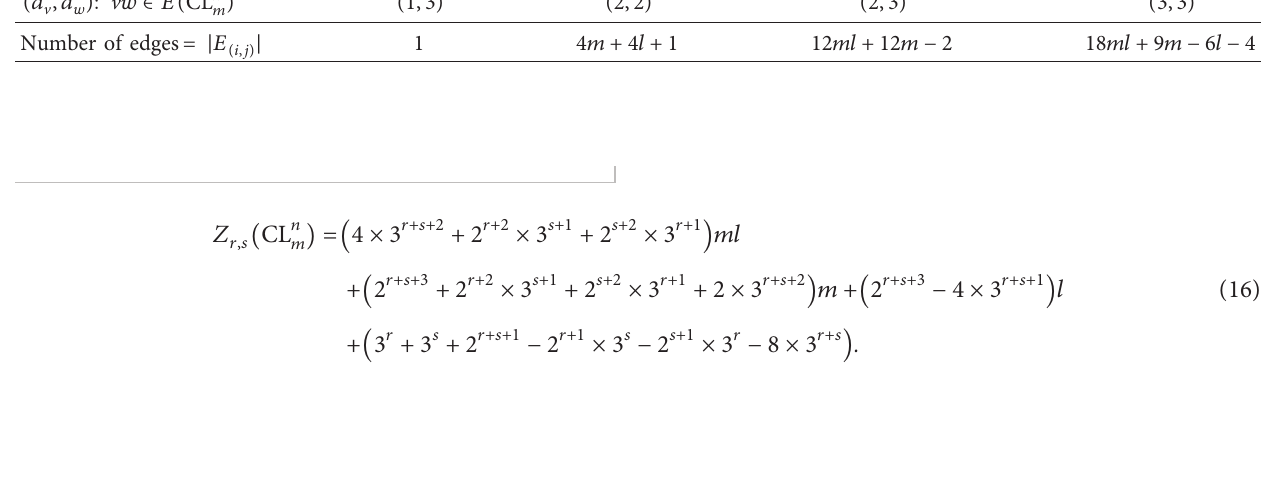
Table 3: Partitioning of the edge set with respect to degrees of end vertices for CL n